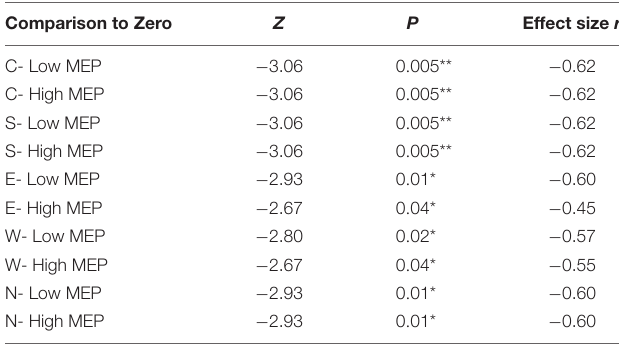
TABLE 3 | Two-tailed Wilcoxon signed rank tests between averaged N100 amplitudes in trials with high and low MEPs tested against the hypothetical median zero (significant deflections from